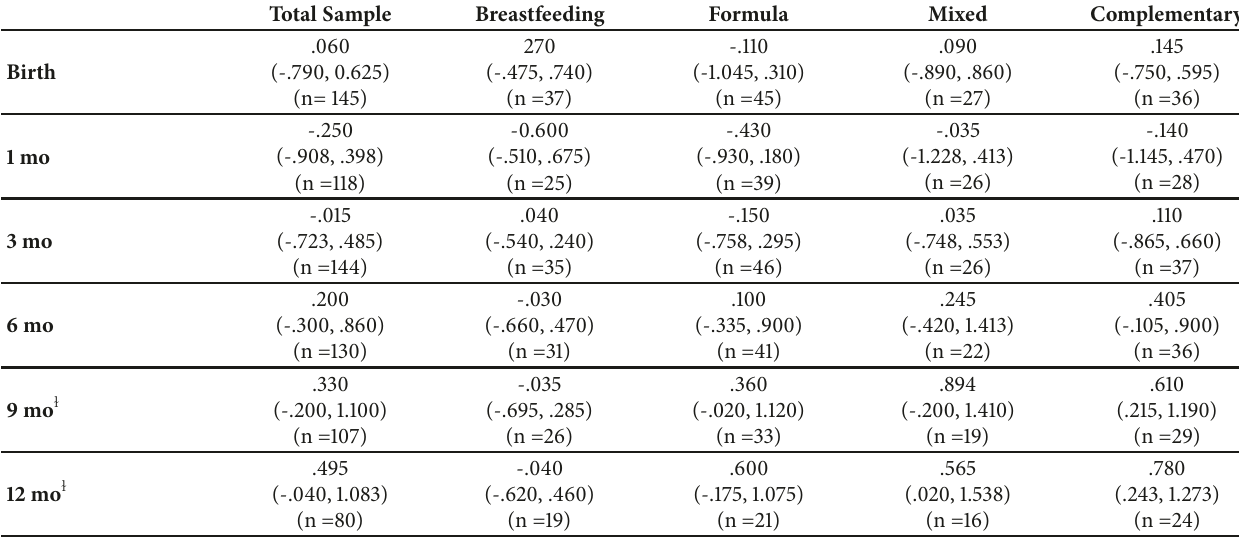
Table 2: Weight-for-age z-scores by feeding type at the time of questionnaire completion. Total Sample